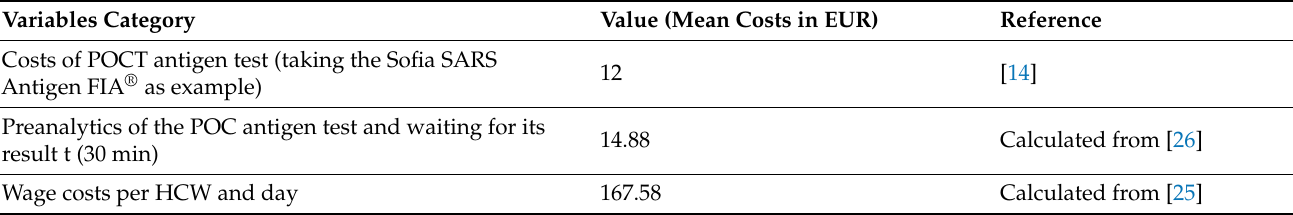
Table 1. Cost parameters used in the model.